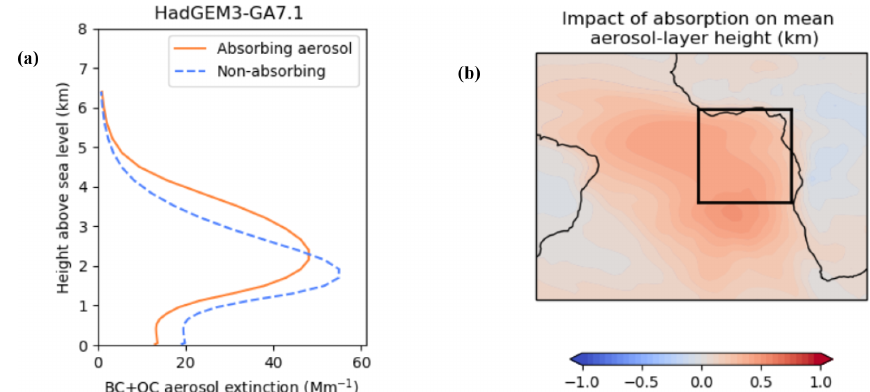
Figure 12. (a) The increase in the mean altitude of BBA in the vertical profile in HadGEM3-GA7.1 version of the climate model (atmosphere only) for August/September over the area shown by the box in (b) . (b) The change in the mean altitude of the aerosol loading determined as the difference in the altitude of the mean profile (as shown in a ) but for each grid box.